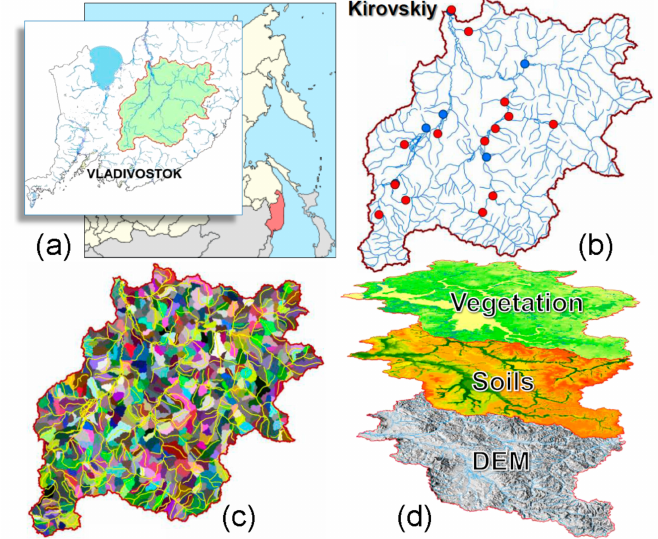
Figure 4. Upper Ussuri River Basin position ( a ) and information set; ( b ) observational network (red circles weather stations, blue circles hydrological gages); ( c ) ECOMAG model unit schematization and ( d ) DEM, soil and vegetation map